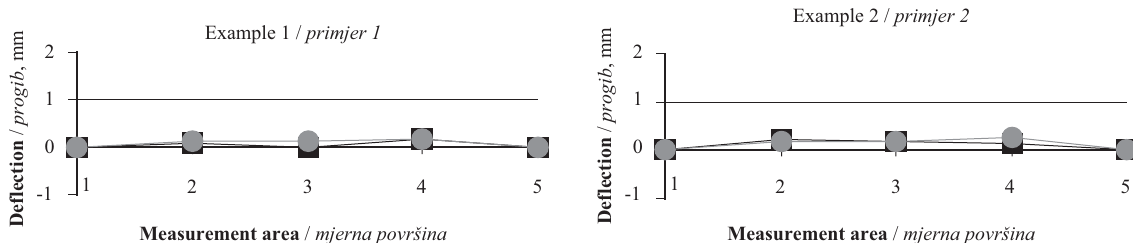
Figure 3 Defl ection of the board asymmetrically veneered on both large sides - signifi cant difference of shrinkage values Slika 3. Progib ploče koja je asimetrično furnirana s obje strane - značajna razlika između vrijednosti utezanja